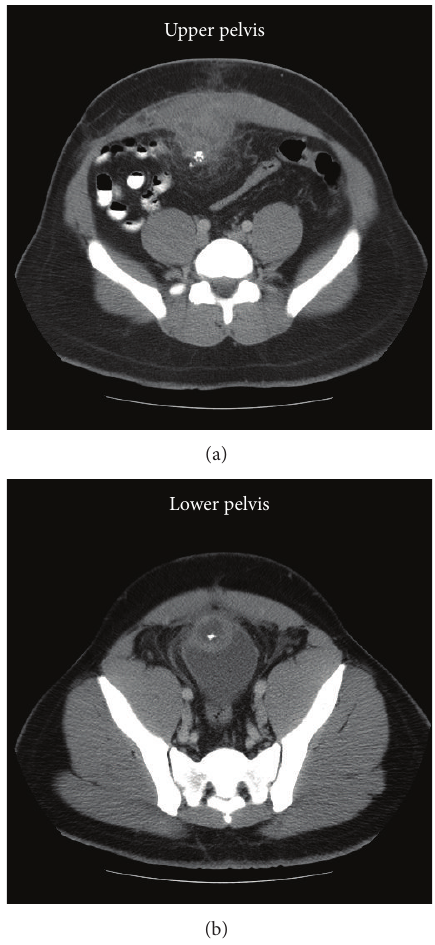
Figure 4: Cystic mass with associated thickening and inflammation adjacent to the abdominal wall and urinary